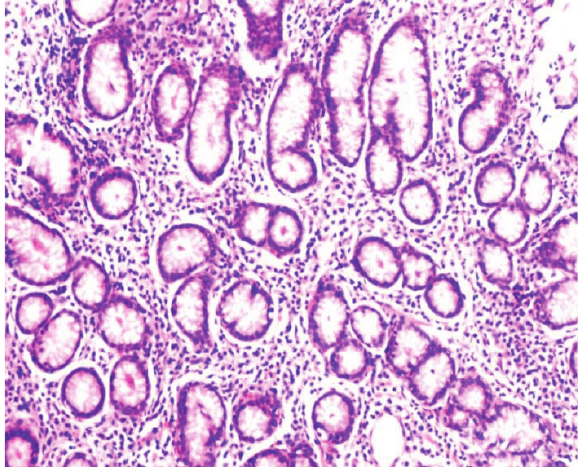
Fig-3: H&E Chronic mild antral